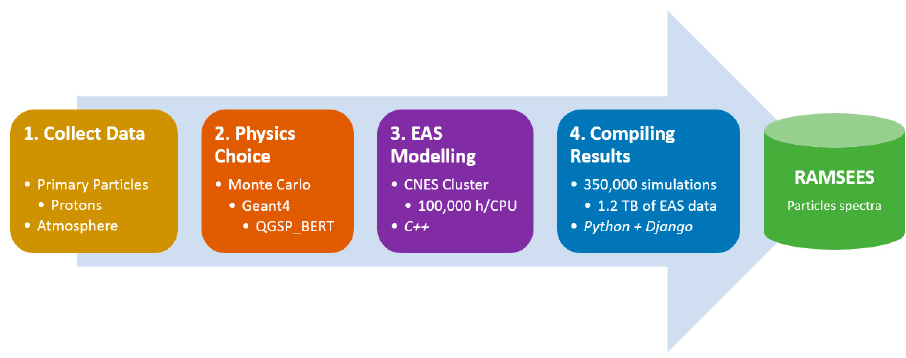
Figure 2. Approach and components needed to simulate an EAS.